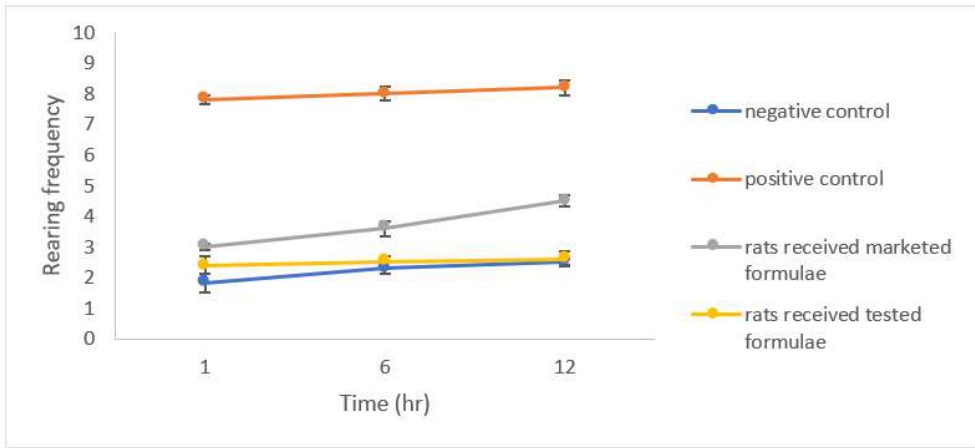
Figure 10. Rearing frequency for different groups of rats .